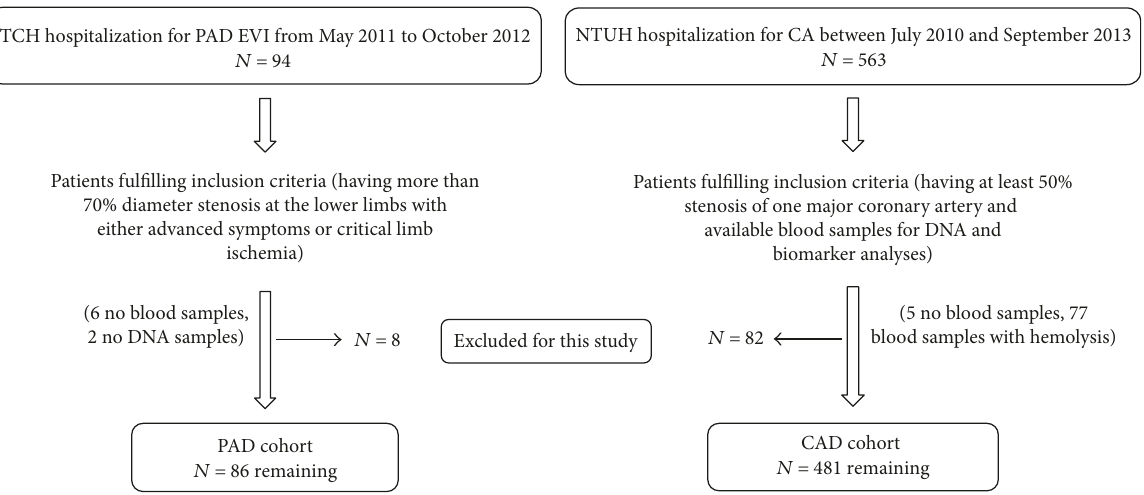
Figure 1: Study inclusion and exclusion criteria fl ow chart. This fl ow chart illustrates the inclusion and exclusion criteria used to screen peripheral artery disease (PAD) patients from Tzu Chi Hospital (TCH) and coronary artery disease (CAD) patients from National Taiwan University Hospital (NTUH), respectively. EVI: endovascular intervention; CA: coronary